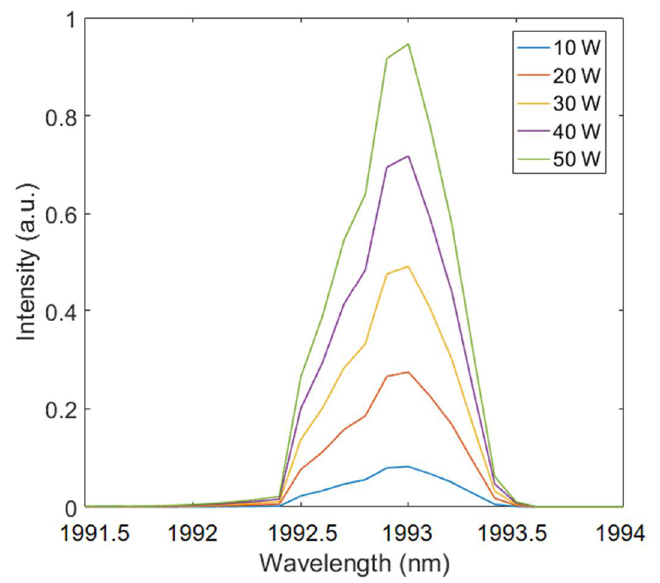
Figure 9. The change of signal laser spectrum under different pump power in 2 m optical fiber.